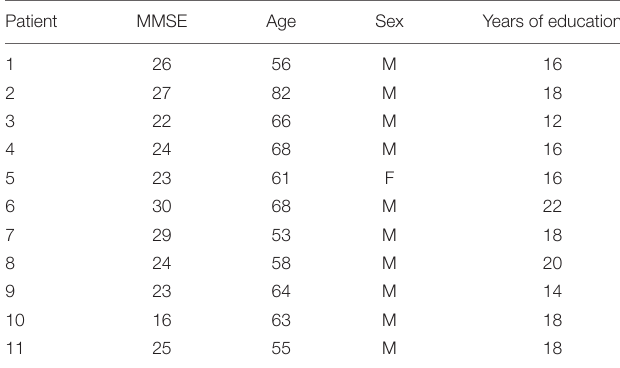
TABLE 1 | Demographic data of the bvFTD